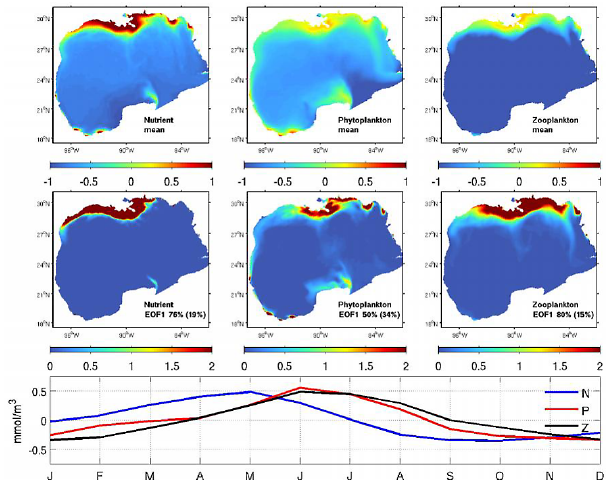
Fig. 11. EOF analyses of surface DIN, phytoplankton and zoo- plankton fields. Mean fields are shown in the top panels (units: mmolNm − 3 , log scale), the first EOF modes and the variance they account for are shown in the middle panels and their corresponding first principle components are shown in the bottom